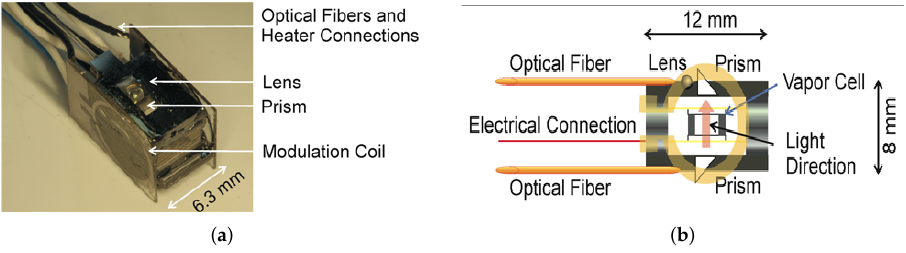
Figure 16. ( a ) Physical packaging of magnetometer; ( b ) magnetometer structure schematic [128].